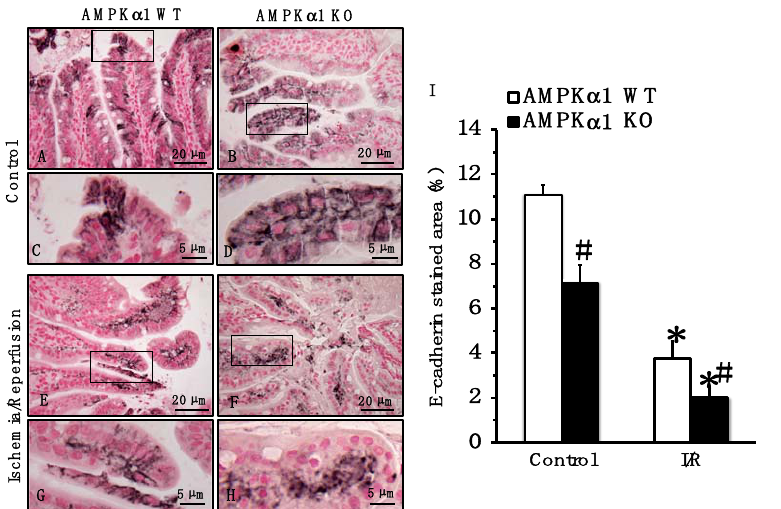
Figure 3. Effect of genetic deficiency of AMPK α 1 on gut localization of E-cadherin. ( A – H ) Represen- tative photomicrographs of immunostaining of E-cadherin in ileum sections. Black boxes in ( A,B,E,F ) indicate regions of magnified insets shown in ( C,D,G,H ). In control AMPK α 1 WT ( A , C ) and KO mice ( B , D ) E-cadherin was mainly found on the epithelial membrane surface. At 4 h after mesenteric I/R, immunostaining moderately decreased in the villi of WT mice ( E , G ) but markedly decreased in KO mice ( F , H ). ( I ) Quantitative analysis of stained area. Data are mean ± SEM of 4 animals for each group; * p < 0.05 versus control mice of the same genotype; # p < 0.05 versus WT group. Scale bars of ( A,B,E,F ): 20 μ m. Scale bars of ( C,D,G,H ): 5 μ m.